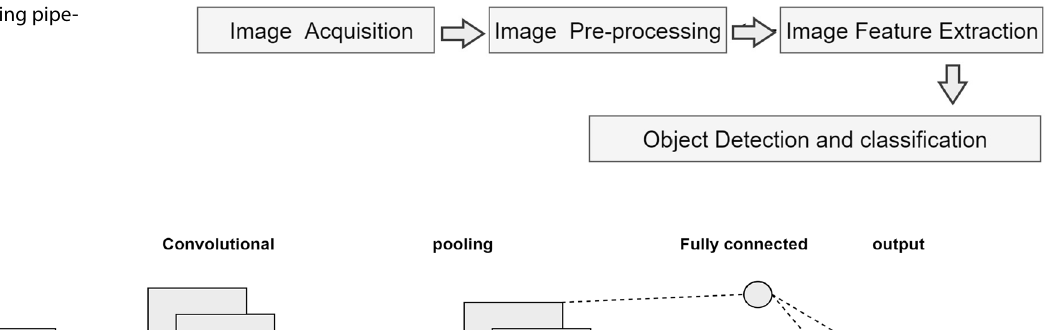
Fig. 1 Image processing pipe- line. Source : [3]